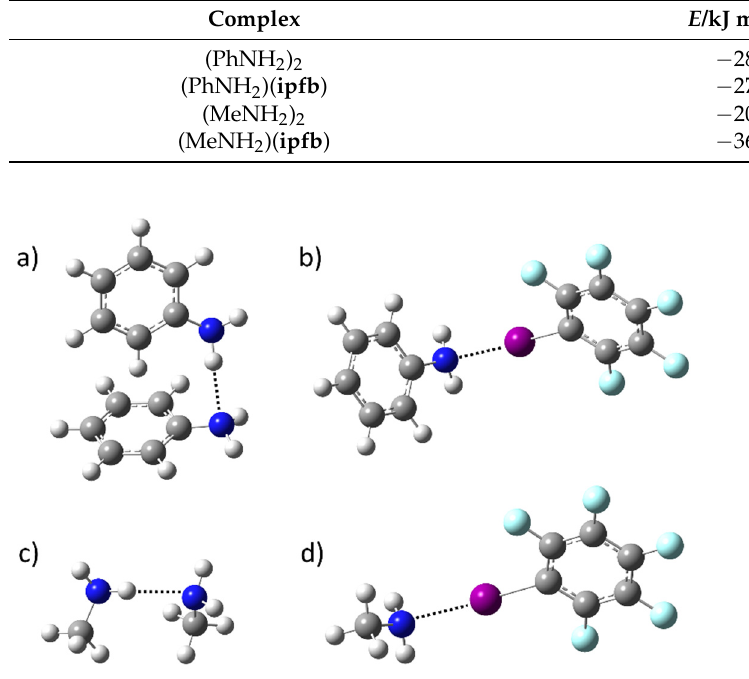
Figure 6. Optimized structures of ( a ) (PhNH 2 ) 2 ; ( b ) (PhNH 2 )( ipfb ); ( c ) (MeNH 2 ) 2 ; ( d ) (MeNH 2 )( ipfb ). Figure